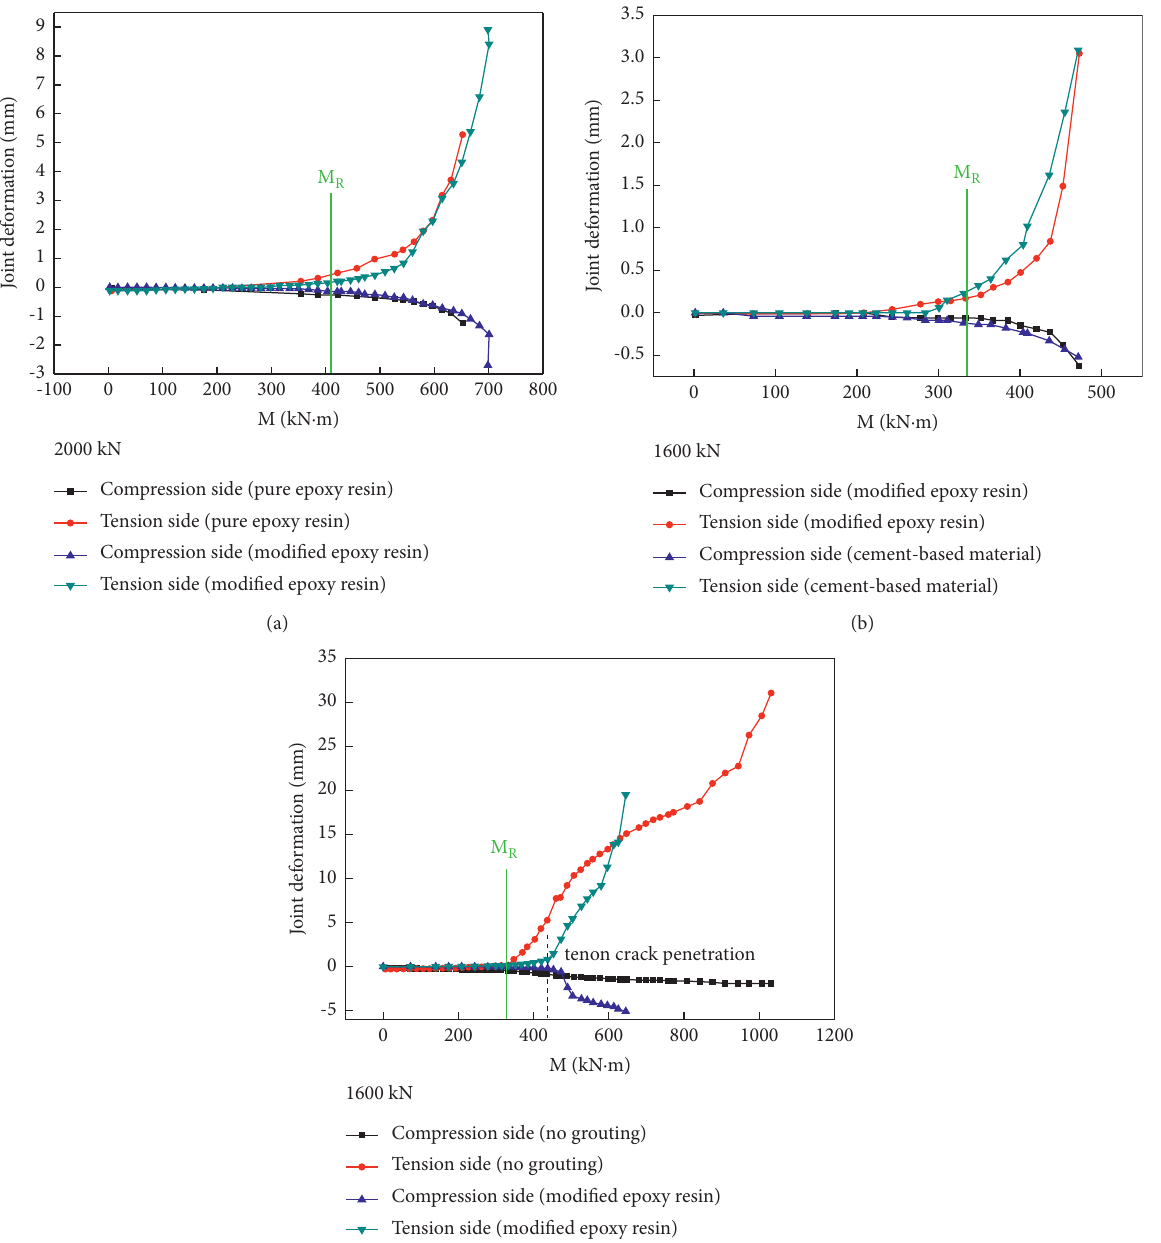
Figure 5: Comparison of joint deformation development for different grouting materials (long single-tenon joint). (a) Pure and modified epoxy resin, (b) modified epoxy resin and cement-based material, (c) modified epoxy resin and no grouting